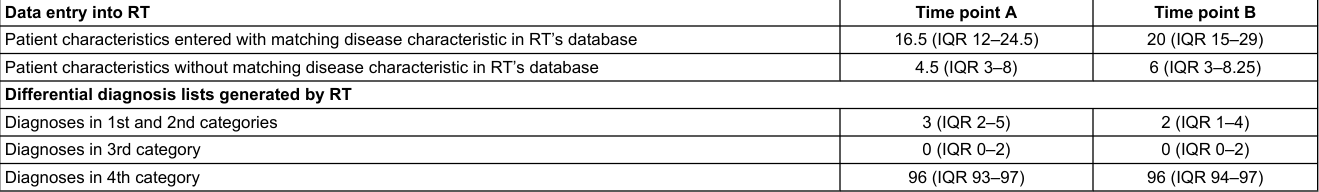
Table 1: Data entry into RT and its output. Data entry into